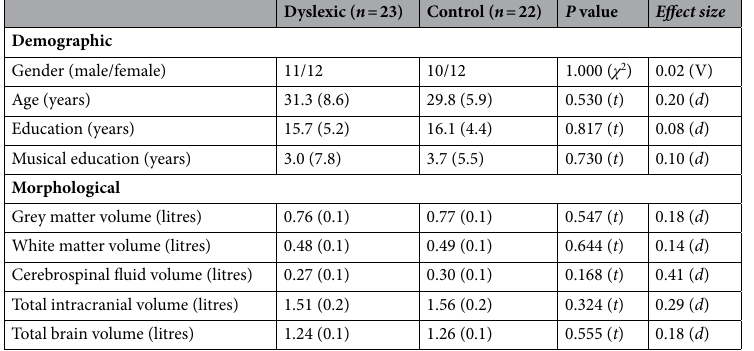
Table 1. Demographic and morphological data. Group sizes (n) and mean values of background variables in the Dyslexic and Control groups with standard deviation in parentheses. P-values show Chi Squared ( χ 2 ) and independent-samples t-test (t) statistics for group comparisons. Effect sizes show Cohen’s d and Cramer’s V for group